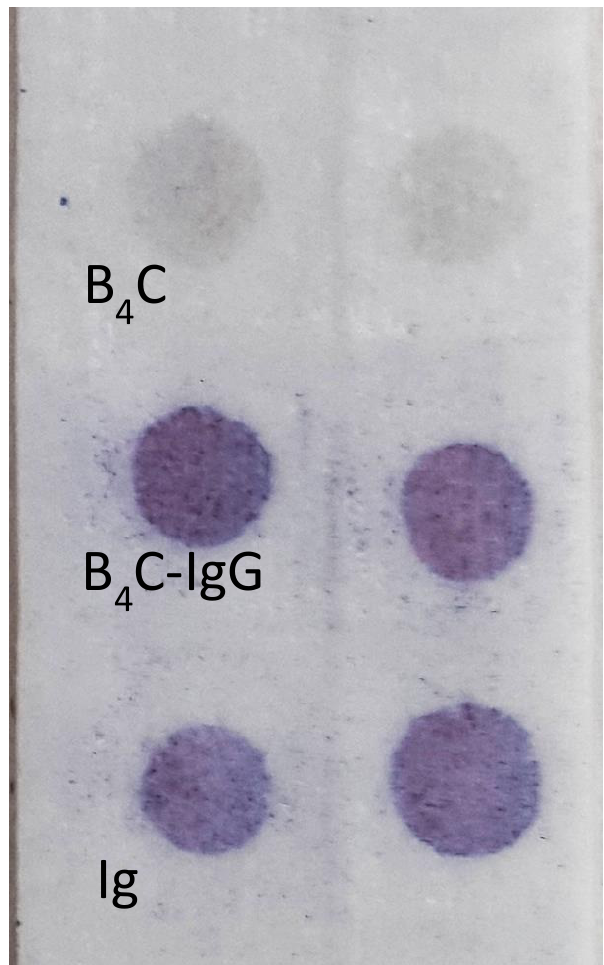
Figure 4. Immunoenzymatic test on 934-AH glass microfiber paper. The presence of immunoglobulin G was detected with protein A/G–peroxidase conjugate. The negative reaction of boron carbide nanoparticles (B 4 C), alone, and the positive result of boron carbide nanoparticles conjugated with human immunoglobulins (B 4 C–IgG), and the positive control human immunoglobulins, alone (IgG). The experiments were performed in duplicate.